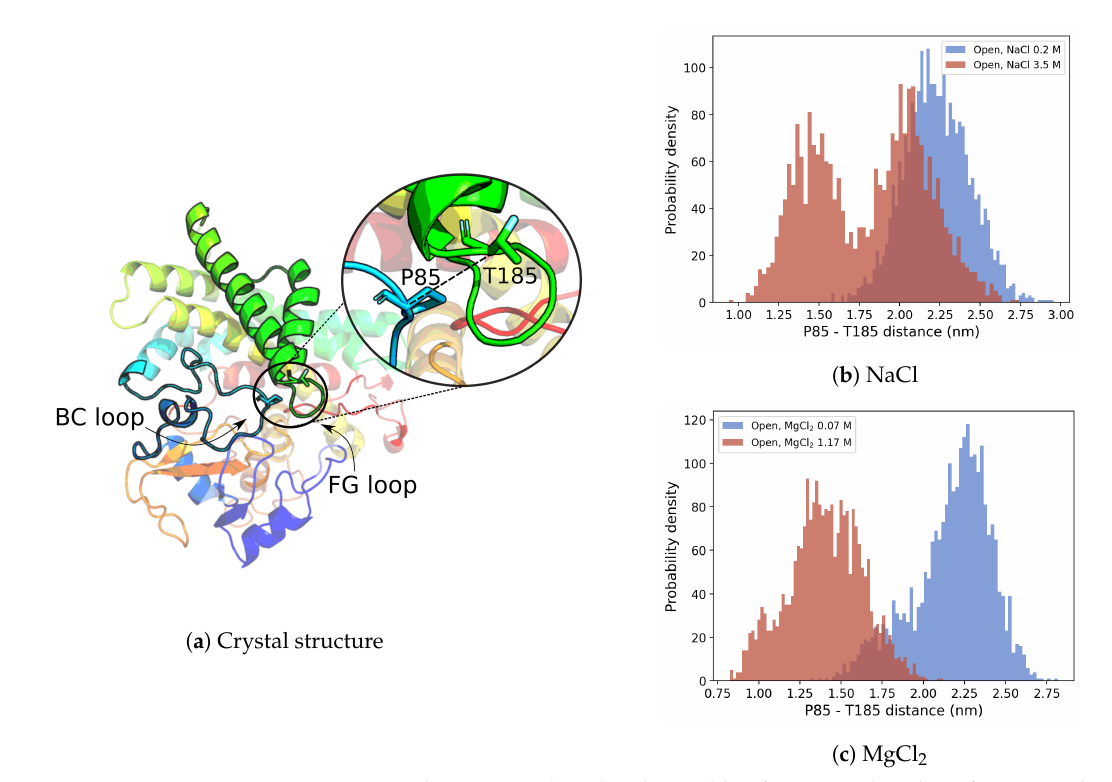
Figure 6. P85–T185 distance used as the observable of open-to-closed conformational transition. ( a ) P85–T185 residues, shown in sticks, their equilibrium distance (dotted line) and position within closed-form OleP crystal structure (pdb id 5MNV, C monomer [5]). ( b , c ) P85–T185 distance distribu- tion along the MD trajectory of the P450 OleP in high- (red) and low- (blue) ionic strength